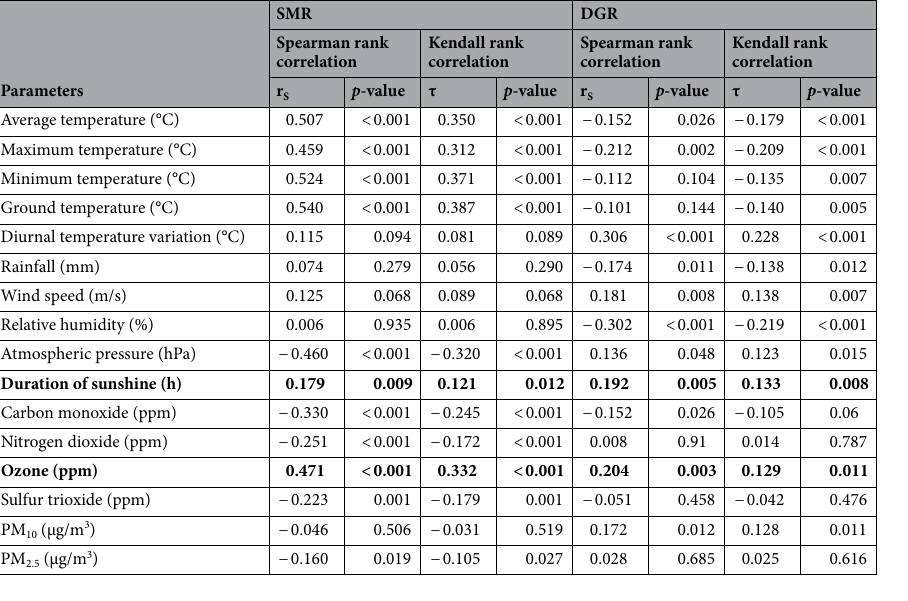
Table 1. Summary of correlation results between COVID-19 and environmental parameters (n = 182) in SMR and DGR. SMR Seoul metropolitan region, DGR Daegu-Gyeongbuk region. Significantly correlated factors in both regions appear in bold